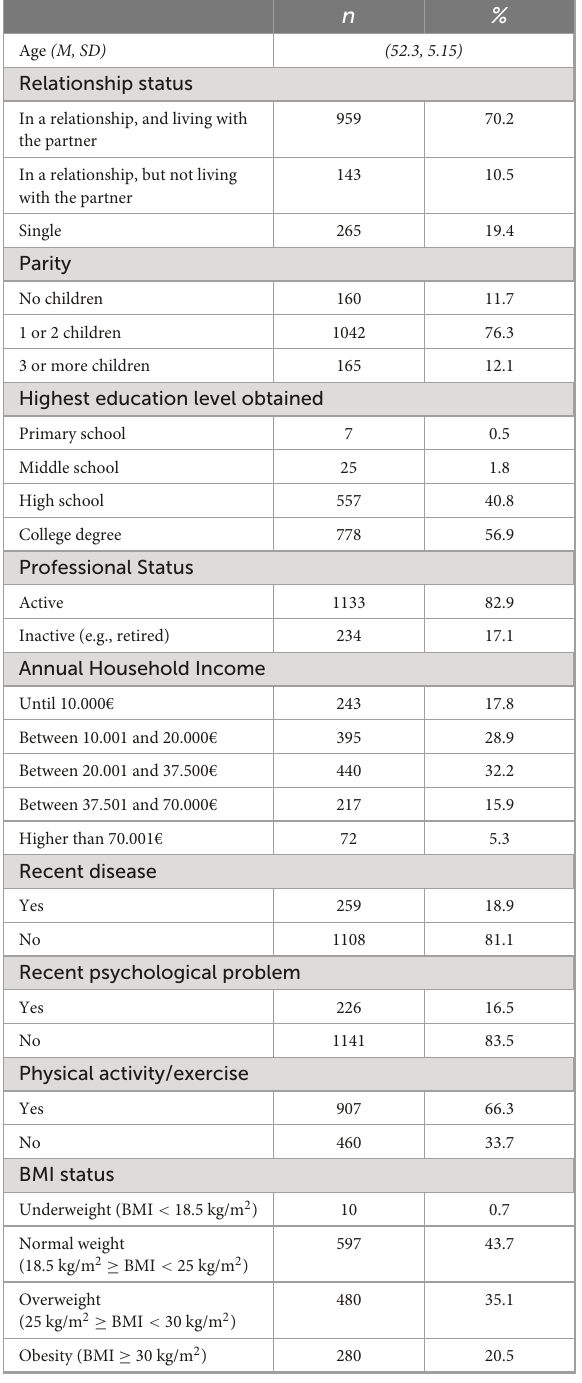
TABLE 1 Characterization of